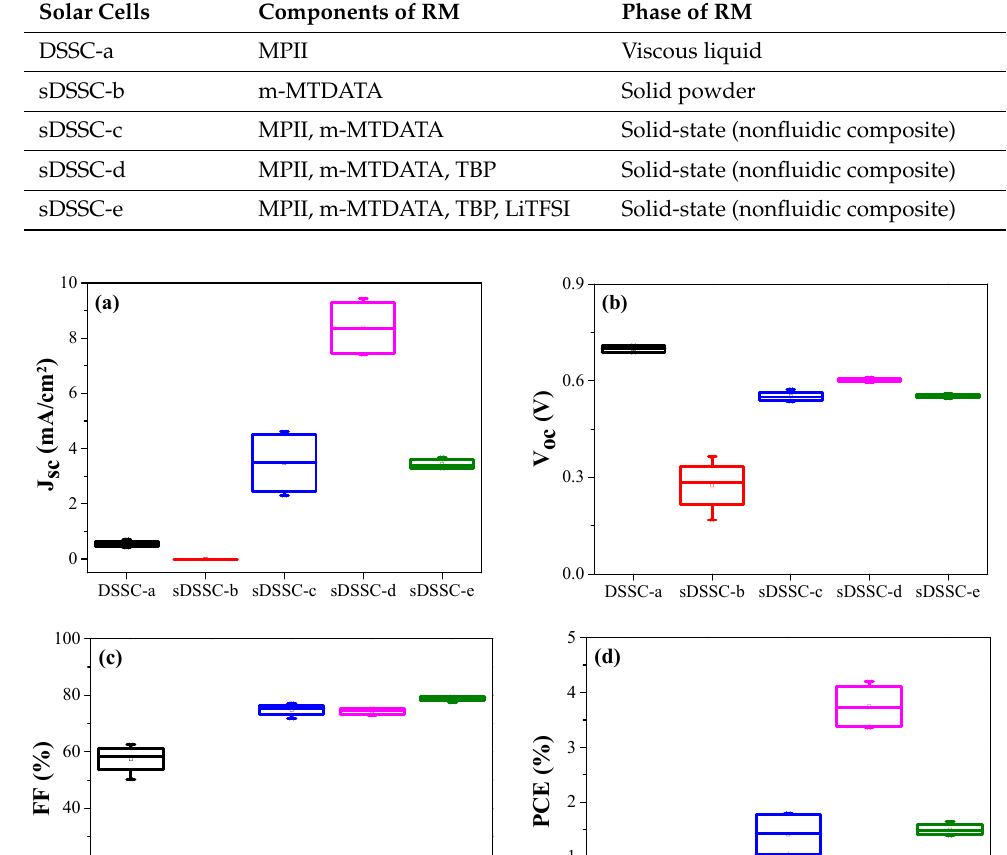
Table 3. Averages and standard deviations of cell performance measured using four cells with five different types of RM.